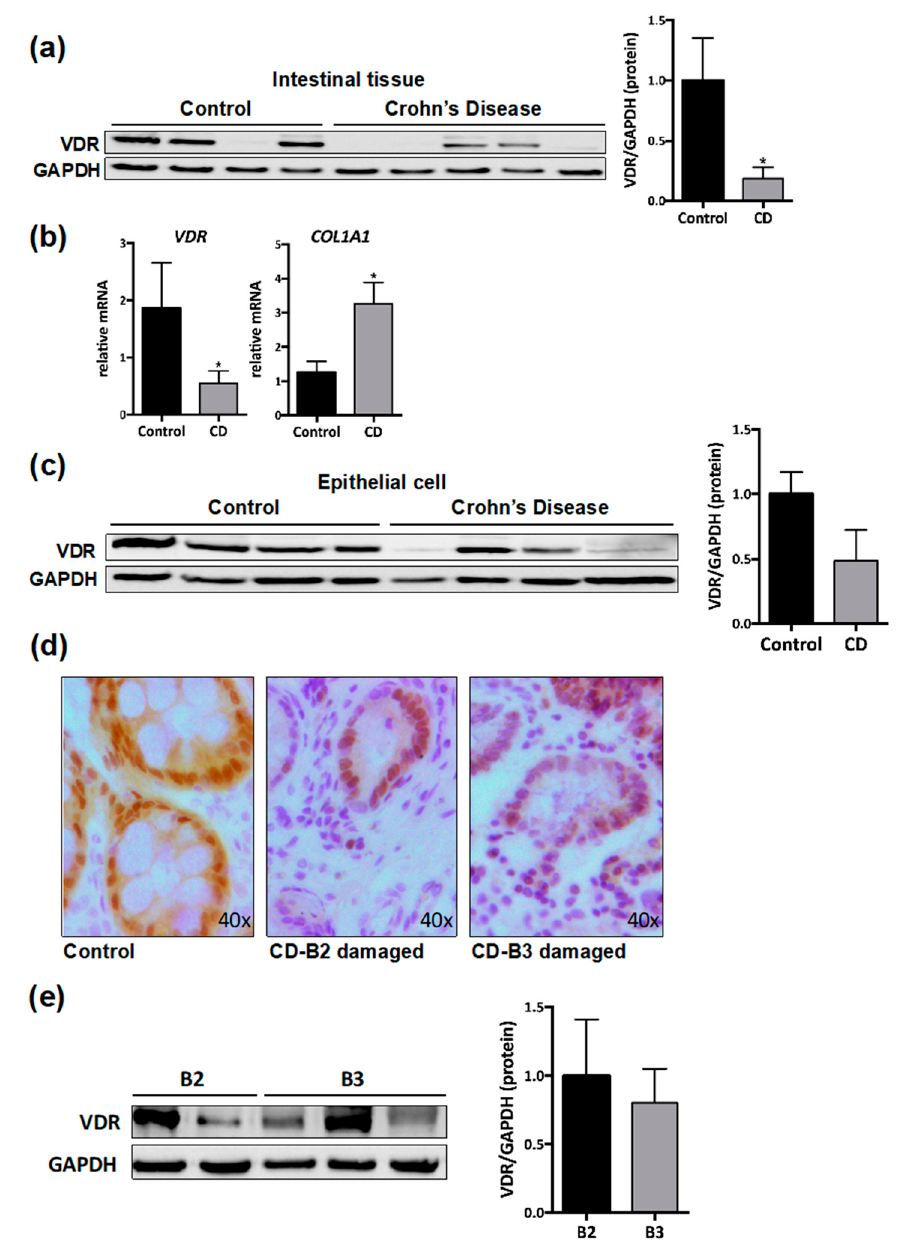
Figure 1. Diminished vitamin D receptor (VDR) expression in damaged intestinal resections from Crohn’s disease (CD) patients. ( a ) A representative Western blot image of VDR protein in lysates of total mucosa from control ( n = 8) and from CD patients ( n = 10). The graph shows VDR protein expression vs. Glyceraldehyde 3-phosphate dehydrogenase (GAPDH) represented as fold induction vs. control mucosa. ( b ) mRNA expression (expressed as fold induction vs. control) of di ff erent genes vs. β -actin in total mucosa from control ( n = 5) and CD patients ( n = 10). In ( a ) and ( b ), bars in graph represent mean ± s.e.m. and significant di ff erences vs. the control group are shown by * p < 0.05. ( c ) Representative Western blot from lysates of epithelial cells isolated from intestinal tissue of controls ( n = 4) and CD patients ( n = 4). Graph shows protein expression vs. GAPDH represented as fold induction vs. control. ( d ) Representative images showing VDR immunostaining in the mucosa of control and CD patients. ( e ) A representative Western blot image of VDR protein in lysates of total mucosa from CD patients with a stenotic (B2, n = 2) or penetrating (B3, n = 3) behavior. The graph shows VDR protein expression vs. GAPDH represented as fold induction vs. B2-CD.